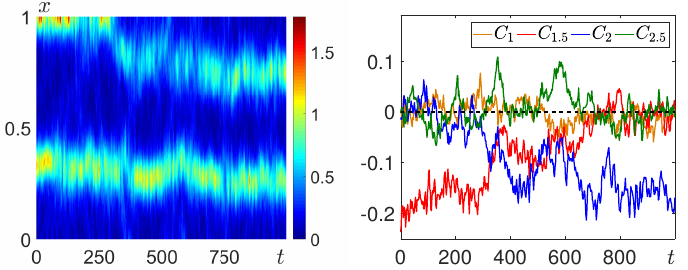
Figure 6. Noise-induced transition 1.5 ↑ → 2 ↑ in Systems (1), (2) with a = d = e = 0.5, b = c = 1, D u = 5 × 10 − 4 , D v = 0.02, ε = 0.1: temporal dynamics of u ( left ) and harmonic coefficients ( right